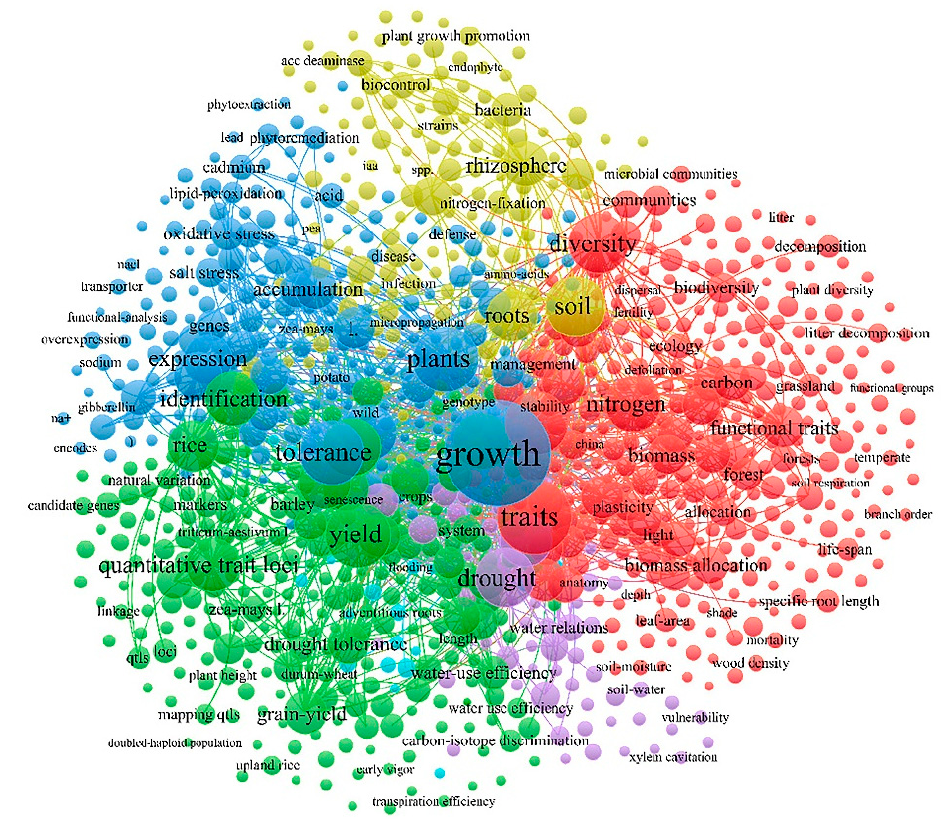
Figure 8. The main keywords of network co-occurrence come from articles. The size of the node indicates the frequency of keyword use. The connection between two nodes indicates the simulta- neous relationship between two keywords. The thickness of the connection between the two nodes indicates the co-occurrence frequency of the two groups of keywords. Different node colors represent different clustering results .